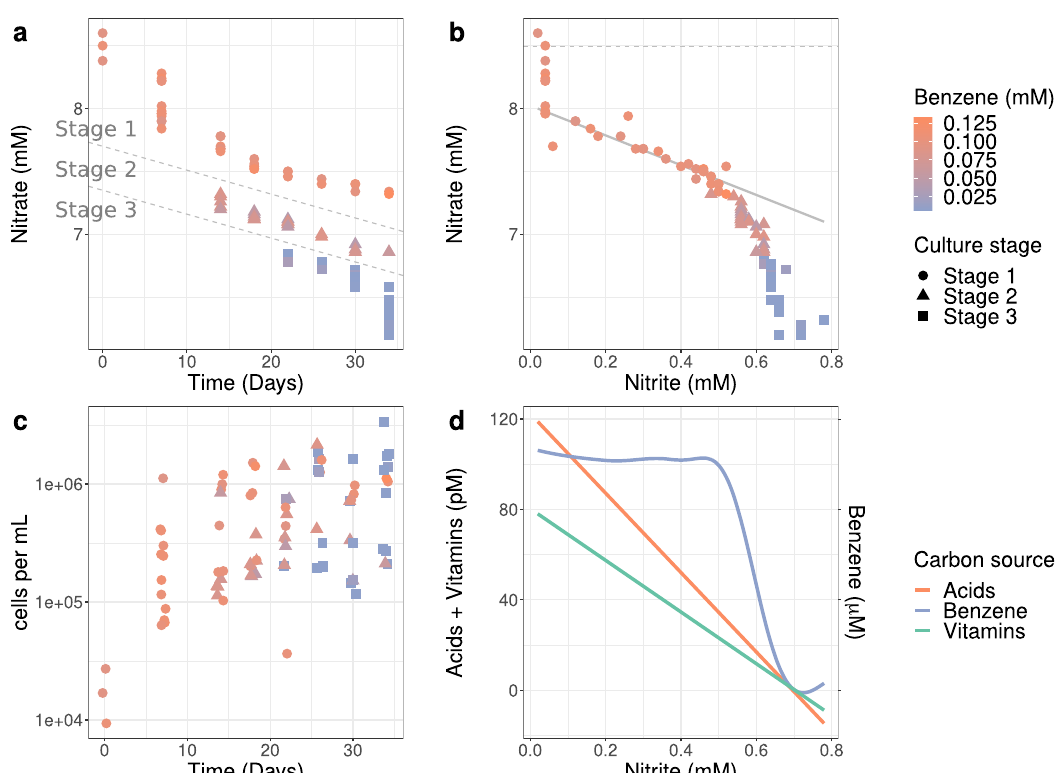
Fig. 3 Progression of benzene degradation in time during the succession experiment. Data analyses of cultures sampled at different time points after inoculation. a Decrease of the nitrate and benzene concentrations. Stages are separated by the grey lines and explained in the text. b Relationships between the onset of benzene degradation, nitrate and nitrite levels and culture stage. The dashed line indicates the average of the measured starting concentration of nitrate. The sloped grey line indicates a stoichiometrical (1:1) ratio of consumption and production of nitrate and nitrite. The intercept of this line was chosen by eye. Note that the culture stage and benzene concentration change only above a nitrite concentration of 0.5 mM or a nitrate concentration below 7.3 mM. c Correlations of cell density, stage and benzene concentration. Data points are jittered relative to the time axis. d Relation between acids (nicotinic, pantothenic and para-aminobenzoic acids), vitamins (biotin and vitamin B12) and benzene consumption with accompanying nitrite levels (Supplementary Fig. 30 for detailed view on each carbon source). The functions were fi tted with a generalized additive model with integrated smoothness estimation. Acids and vitamins were additives in the original media. Numbers and increments of left and right y-axis are the same. Note the initial consumption of acids followed by vitamins, only after which benzene consumption starts. The sudden drop in the fi tted benzene consumption plot coincides with the decrease in nitrite production in stage 2 (Supplementary Fig. 31 for